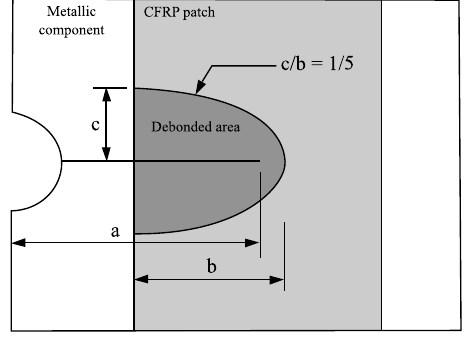
Figure 8. Definition of the debonded area.